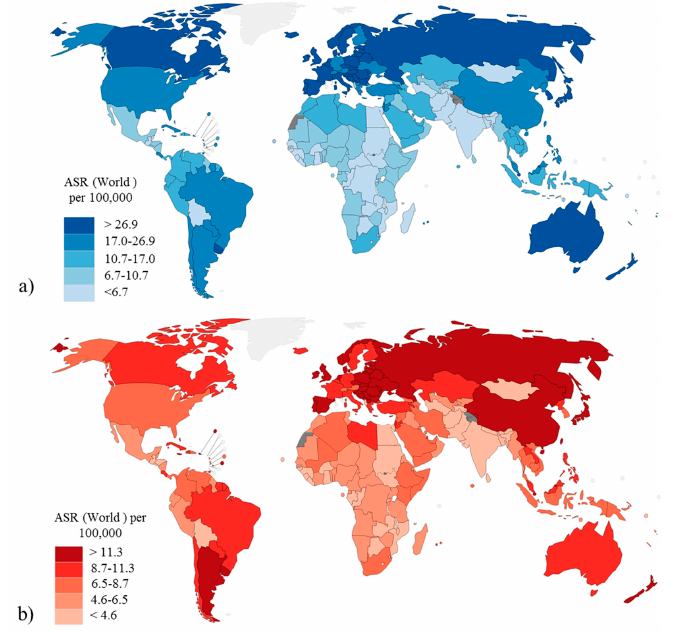
Figure 1. World and colorectal cancer in 2020. ( a ) Estimated age standardized incidence rate (100,000) for world countries; ( b ) Estimated age standardized mortality rate (100,000) for the world countries. Modified from Global Cancer Observatory (GBO) 2020, International Agency for Research on Cancer, World Health Organization [6].